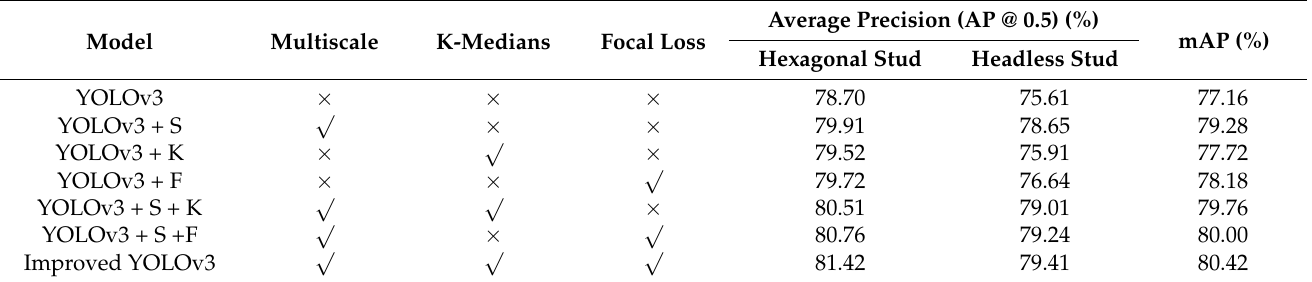
Table 4. Experiments with different modules on the studs dataset. S: multiscale training and